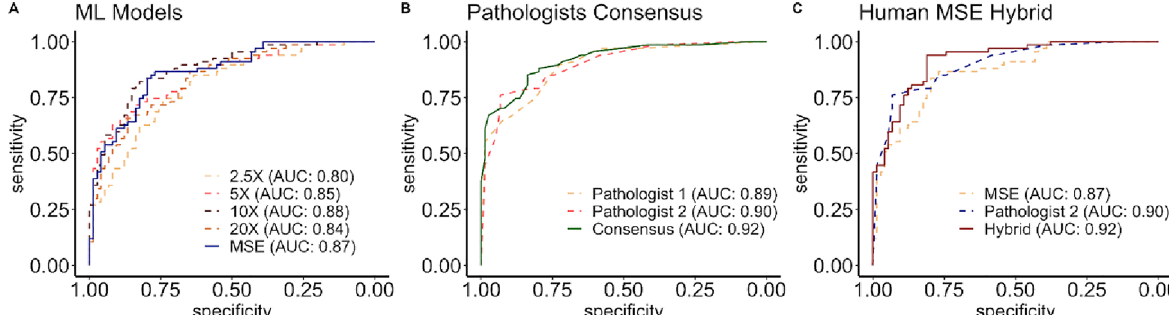
Figure 2. ROC curves for the ML classifiers, pathologists, and hybrid models on the WCM test data. ( A ) compares the model performance of the single-scale ensembles and the multi-scale ensemble. (MSE). The performance of the semiquantitative predictions of two expert neuropathologists and the two-pathologist averaged consensus are compared in B ). ( C ) compares the predictions of the top-performing neuropathologist with the MSE, and the hybrid model generated by naïve averaging of pathologist and MSE